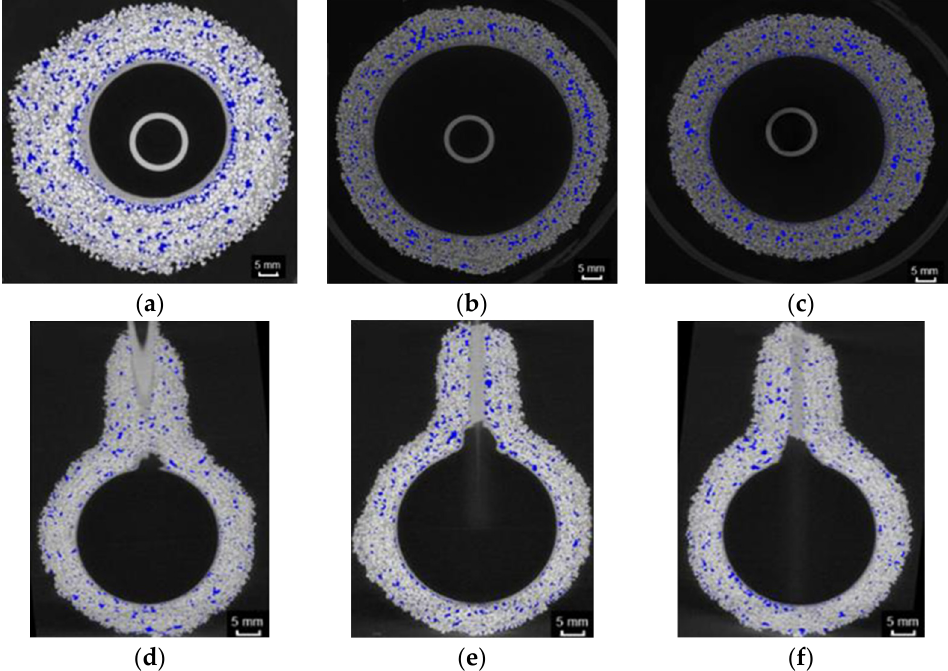
Figure 6. Thickness and porosity of the ceramic samples determined by CT. Cross-section of samples: M1 ( a ), M2 ( b ) and M3 ( c ). Longitudinal section of samples: M1 ( d ), M2 ( e ) and M3 ( f ).